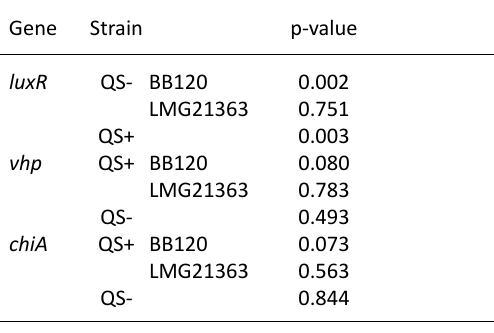
table 4. Pairwise comparison (p-value) of gene expression ( luxR, vhp, chiA ) between different Vibrio strains (BB120, LMG21363, QS+, QS-) Gene Strain p-value